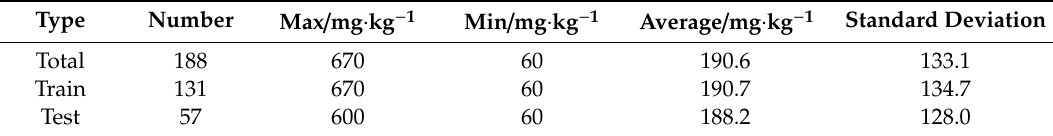
Table 3. Soil-available potassium sample